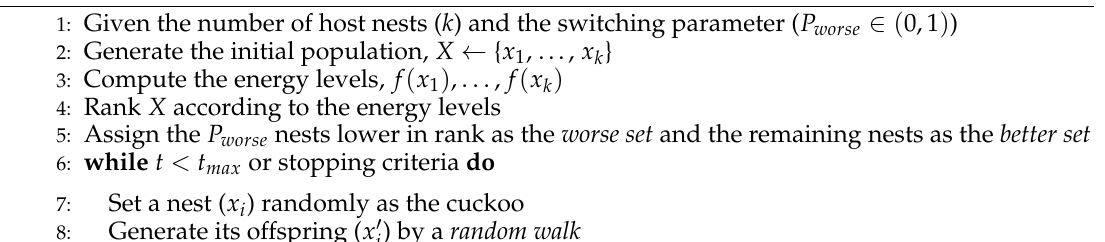
Algorithm 1: CuckooVina for protein–ligand docking.